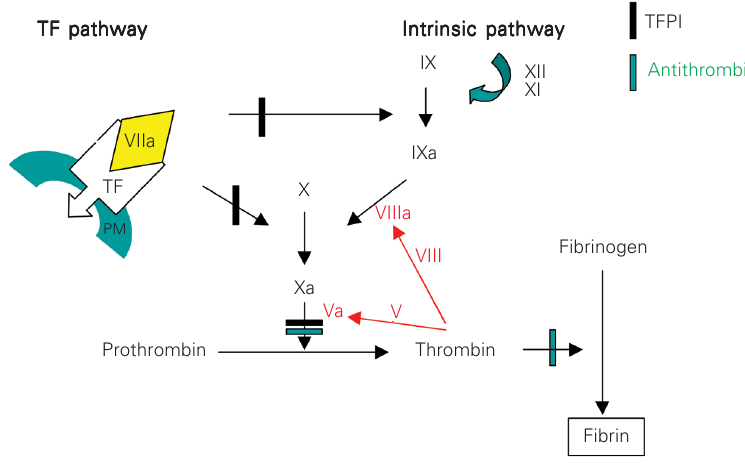
Figure 1. Scheme of the coagulation mechanism showing the main steps of the extrinsic coagulation pathway (tissue factor (TF) pathway) that is reported to be the primary trigger of clotting in vivo . The extracellular domain of TF binds native factor VII. Activation of factor VIIa after complex formation with TF is followed by the conversion of factor X to factor Xa. Both the intrinsic and the extrinsic pathways converge at the conversion of factor X to factor Xa, which yields thrombin. Thrombin promotes its own formation by a positive feedback mechanism through activation of factor V and factor VIII. Two additional endogenous inhibitory mechanisms include antithrombin (which binds unfractionated and low molecular weight heparin and pentasaccharide to inhibit factor IIa and factor Xa) and TF pathway inhibitor (TFPI) which blocks the formation of factor Xa. Reproduced with permission from Ref. 7. PM = plasma